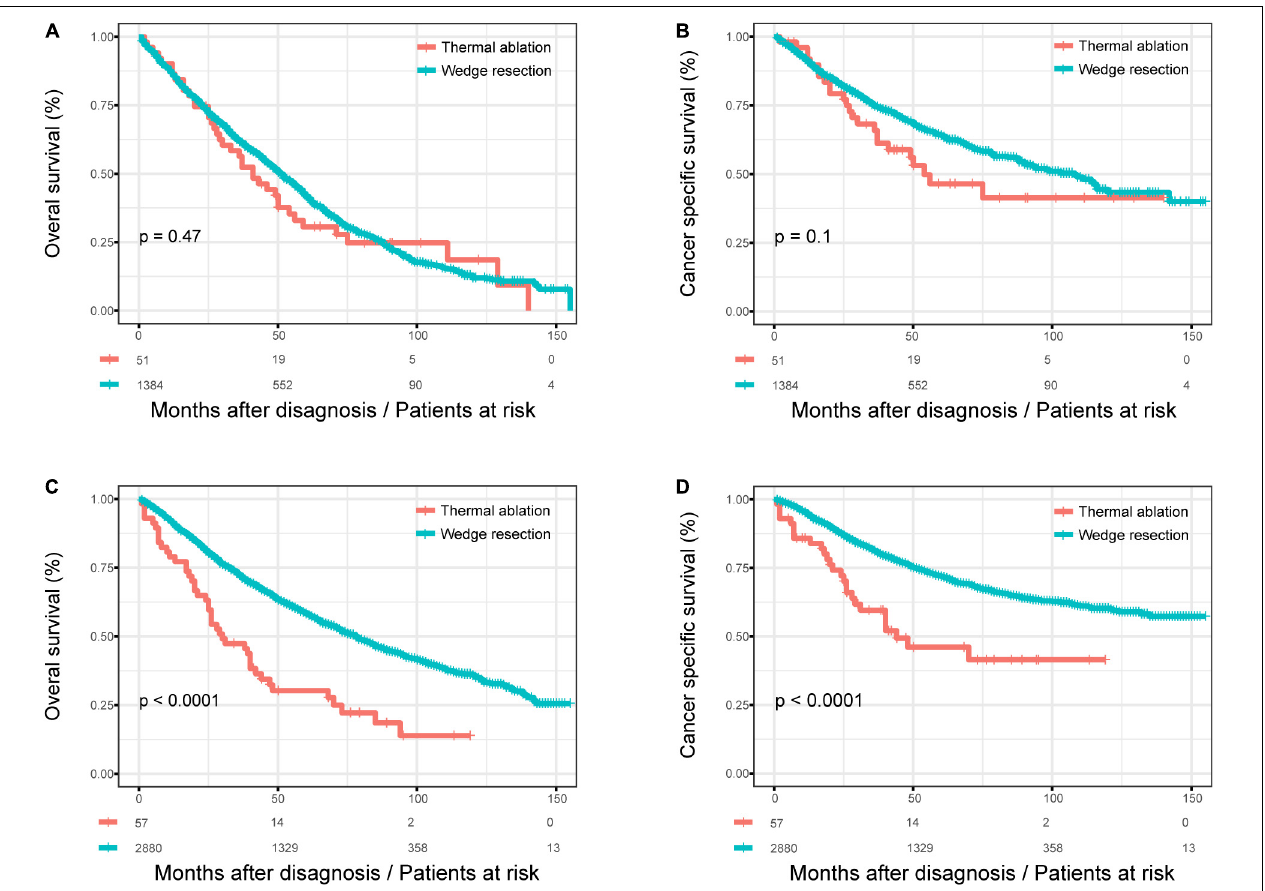
FIGURE 3 | The subgroup analysis of OS and CSS in stage I NSCLC patients who received thermal ablation or wedge resection. (A) The OS curve of stage I NSCLC patients aged > 75 years who received thermal ablation or wedge resection ( χ 2 = 0.515, p = 0.47). (B) The CSS curve of stage I NSCLC patients who received thermal ablation or wedge resection aged over 75 years ( χ 2 = 2.708, p = 0.1). (C) The OS curve of stage I NSCLC patients < 75 years who received thermal ablation or wedge resection ( χ 2 = 32.190, p < 0.0001). (D) The CSS curve of stage I NSCLC patients < 75 years who received thermal ablation or wedge resection ( χ 2 = 20.966, p <